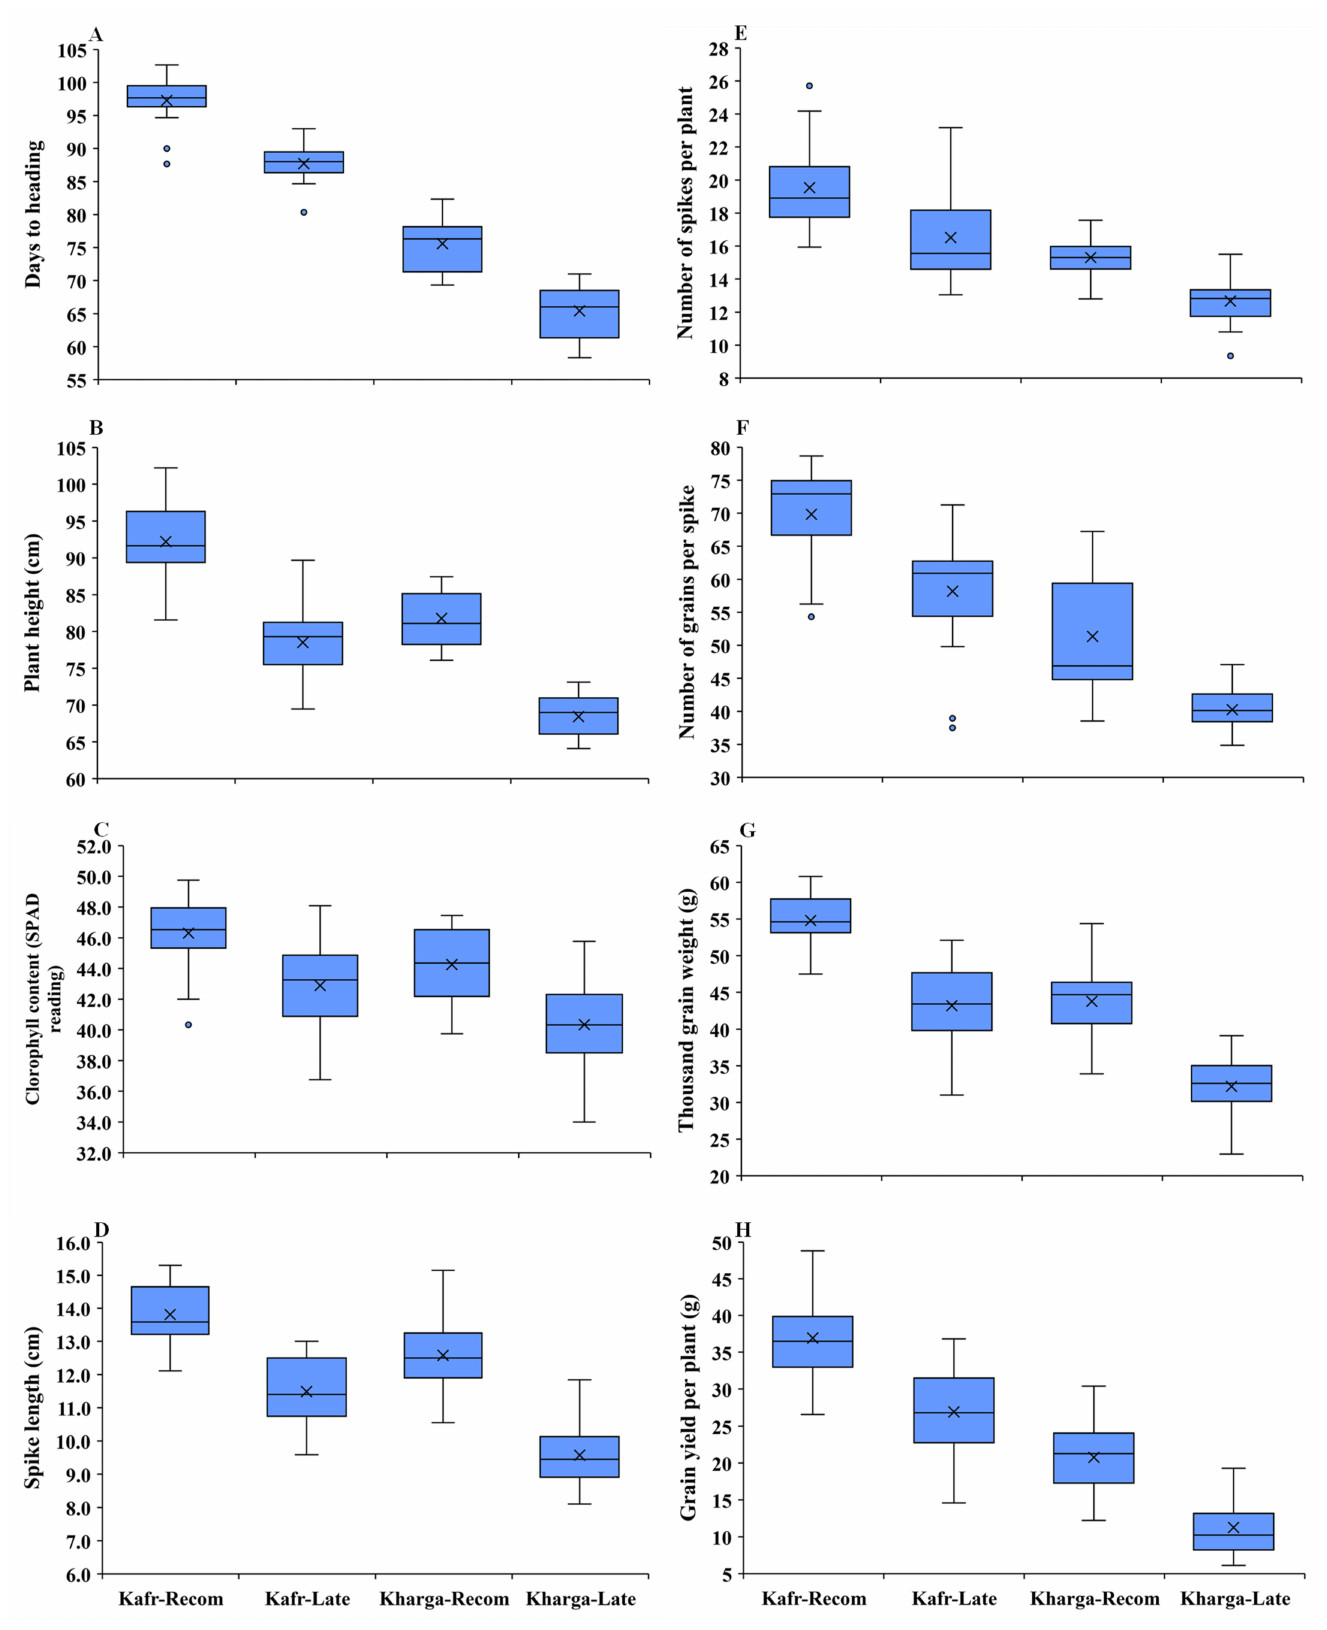
Figure 2. Boxplots with minimum, maximum, median, and mean values for days to heading ( A ), plant height ( B ), chlorophyll content ( C ), spike length ( D ), number of spikes per plant ( E ), number of grains per spike ( F ), Thousand grain weight ( G ), and grain yield per plant ( H